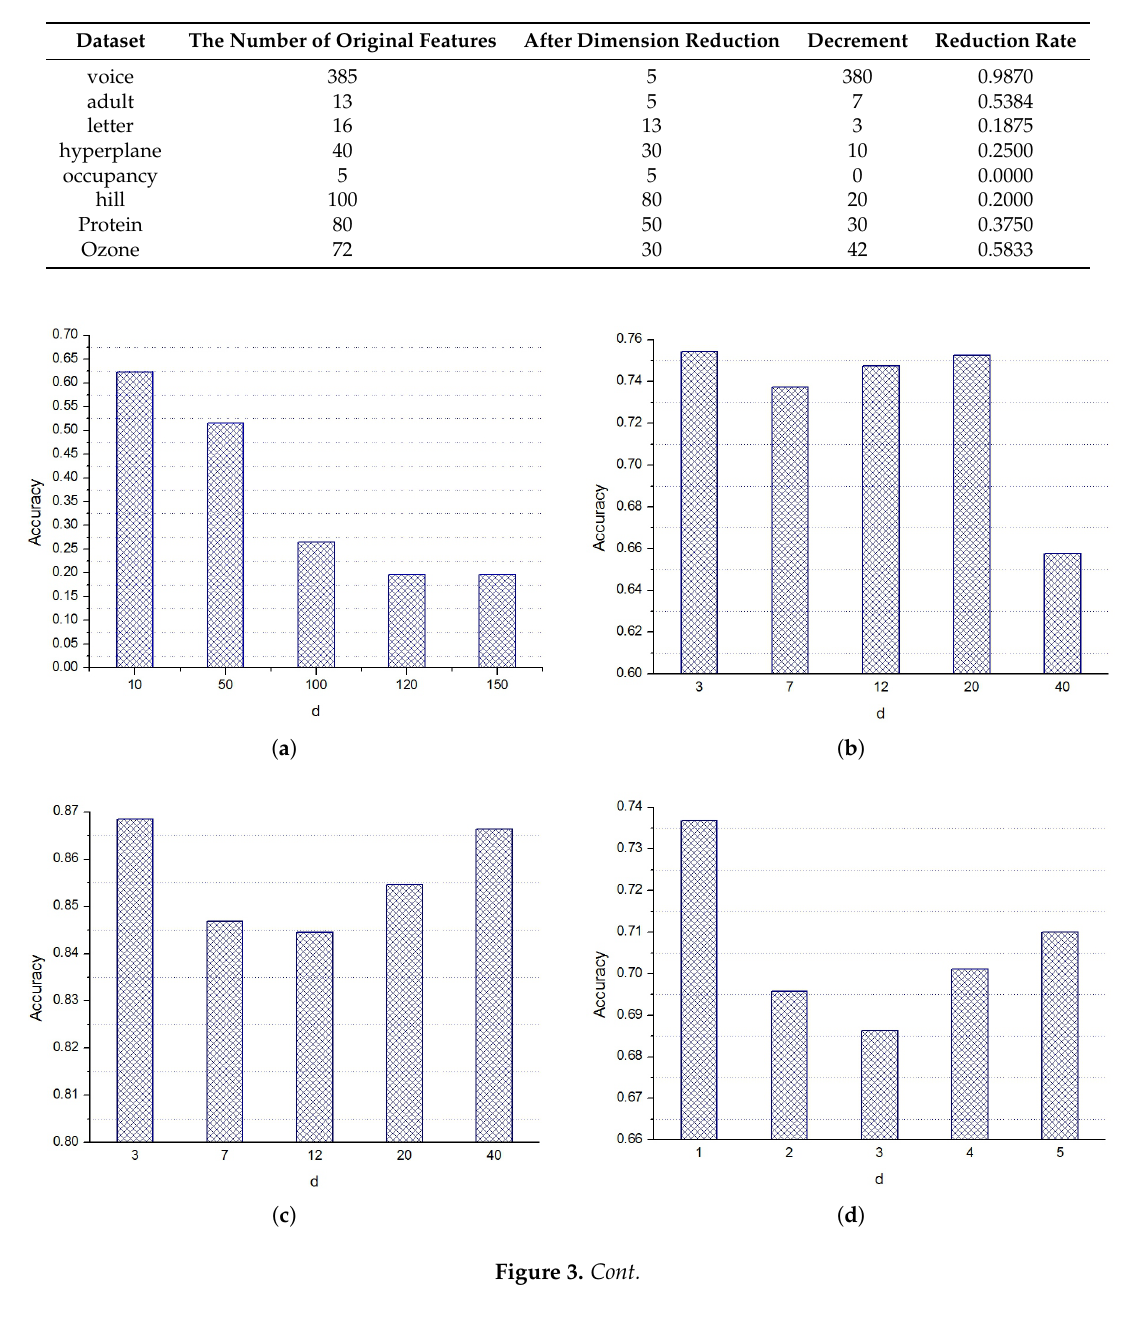
Table 4. The dimension reduction result of CELM testing in Table 2.